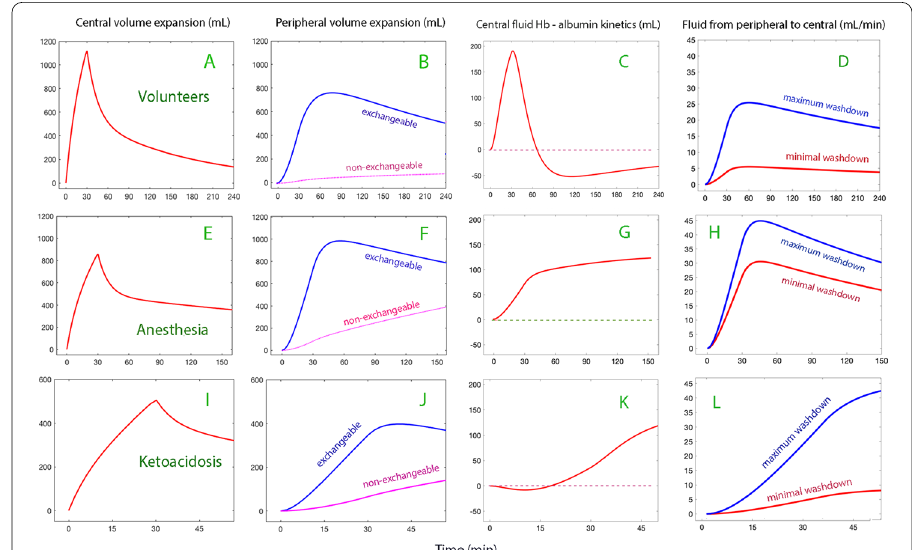
Fig. 3 Volume kinetic analyses based on the dilution of blood Hb. The subplots in the top row show the distribution of infused fluid in volunteers between the A central and the B peripheral fluid compartment, C the excess fluid in the central compartment when analyzing the volume kinetics based on Hb minus the volume expansion as obtained when albumin was used as the marker of plasma dilution. D Return flow of fluid from the peripheral to the central space (the plasma) when contrasting the influence of high-degree versus low-degree interstitial washdown (approximately 5–95% span). Subplots E – H show the same calculations when applied to patients under general anesthesia and Subplots I – L when applied to patients with